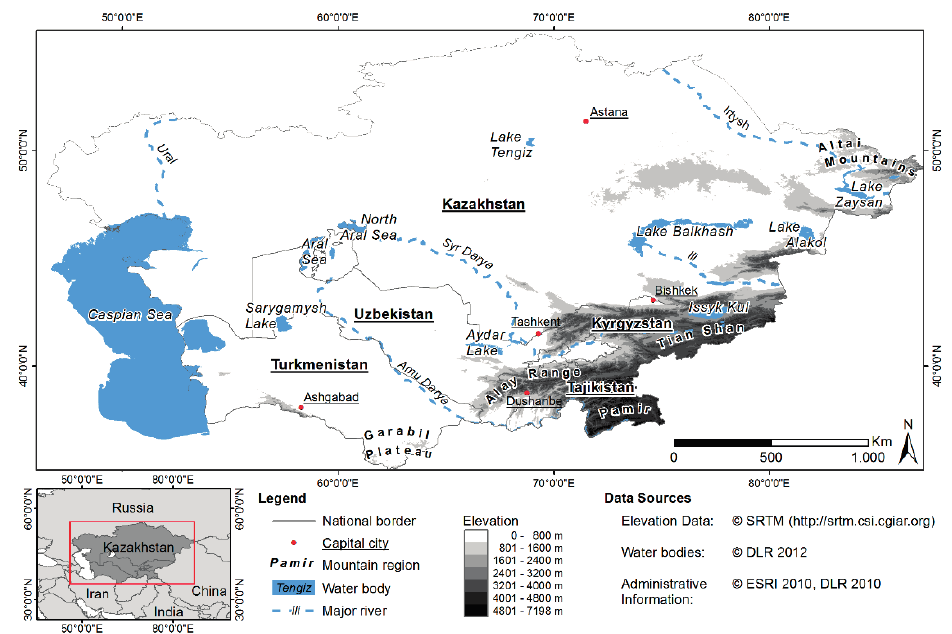
Figure 1. Overview of Central